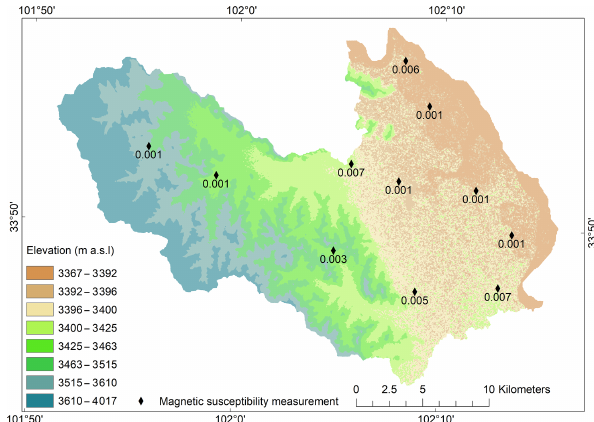
Figure A1. Magnetic susceptibility measurements (10 − 3 SI units) ensured the suitability of applying MRS in the study area.